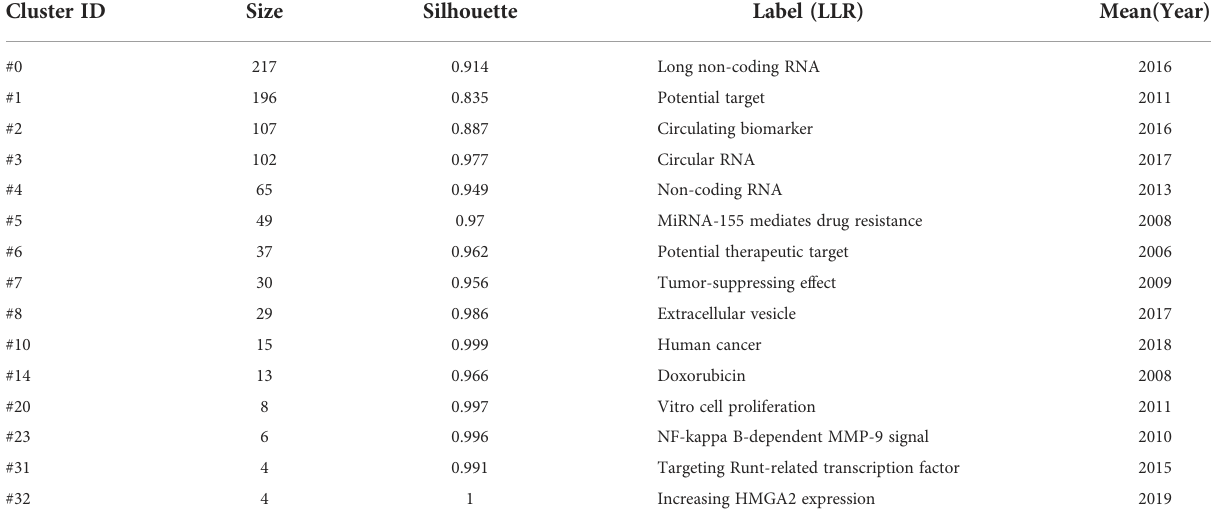
TABLE 2 Main clusters of co-cited references.